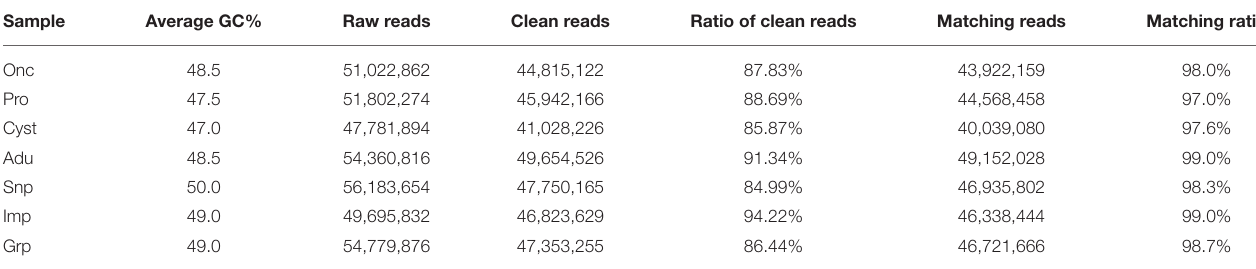
TABLE 2 | RNA-seq reads for transcriptomes aligned to the assembled genome of T. multiceps . Sample